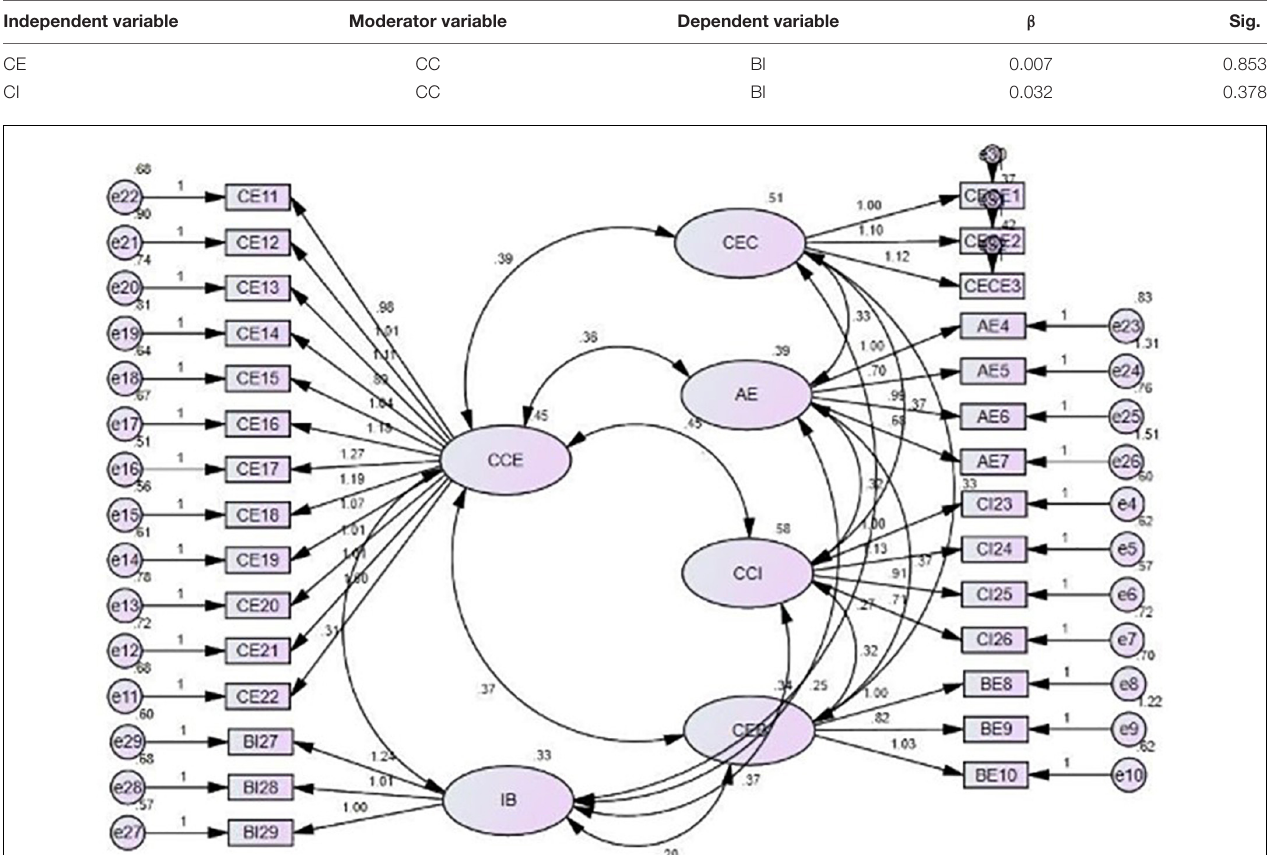
TABLE 4 | Moderation regression analysis.